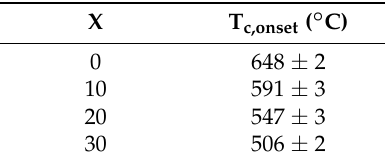
Table 1. Onset temperature for crystallization, T c,onset , in (Ni 0.6 Nb 0.4 ) 100 − x Zr x membranes as a function of Zr content, x.